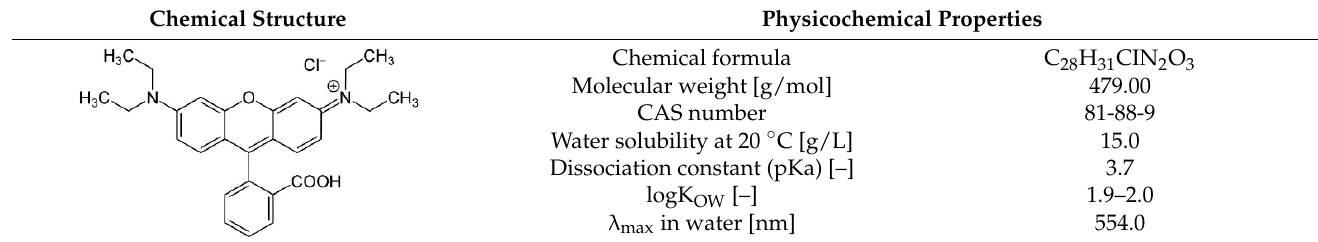
Table 1. Molecular structure and some physicochemical properties of RhB [5]. Chemical Structure